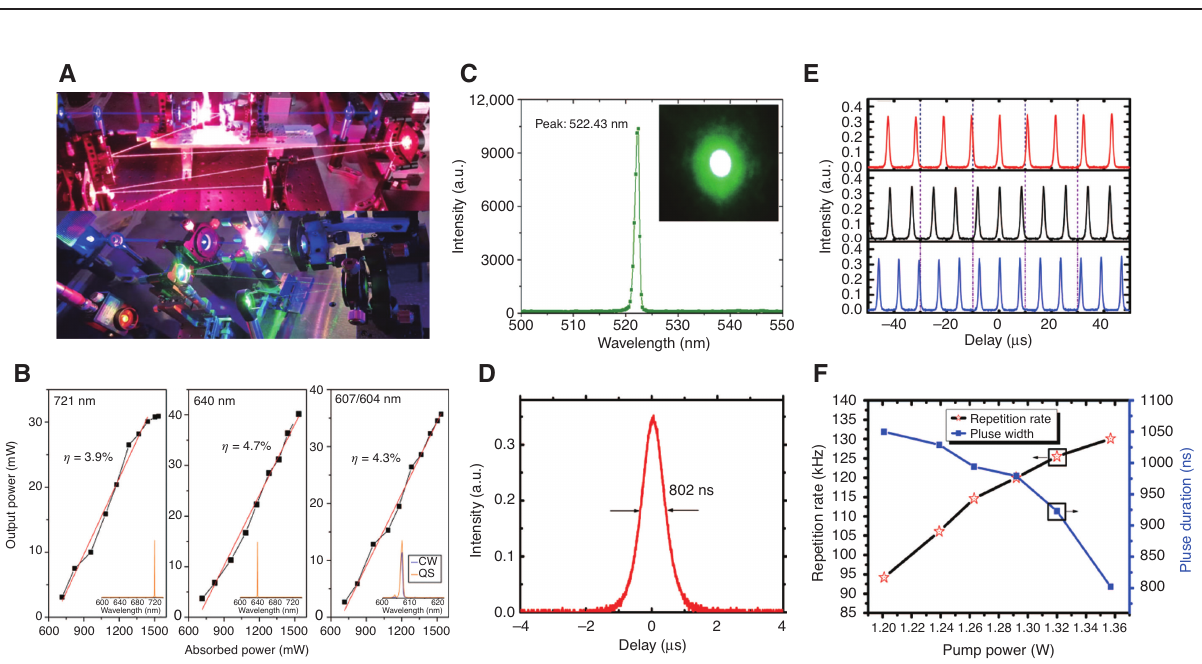
Figure 10: Q-switched solid-state crystal lasers based on nanomaterial SAs in the visible region. (A) Photograph of the red/green Q-switched Pr: YLF laser. (B) Output powers and spectra at different wavelengths. (C) Optical spectrum of the Q-switched Pr: YLF laser at 522 nm; inset: photograph of the green laser beam spot. (D) Single pulse envelope, (E) pulse trains, and (F) pulse repetition rate and pulse duration of the orange Q-switched Pr: LiYF laser. (B) Adapted from Ref. [134], Copyright 2017, Published by 4